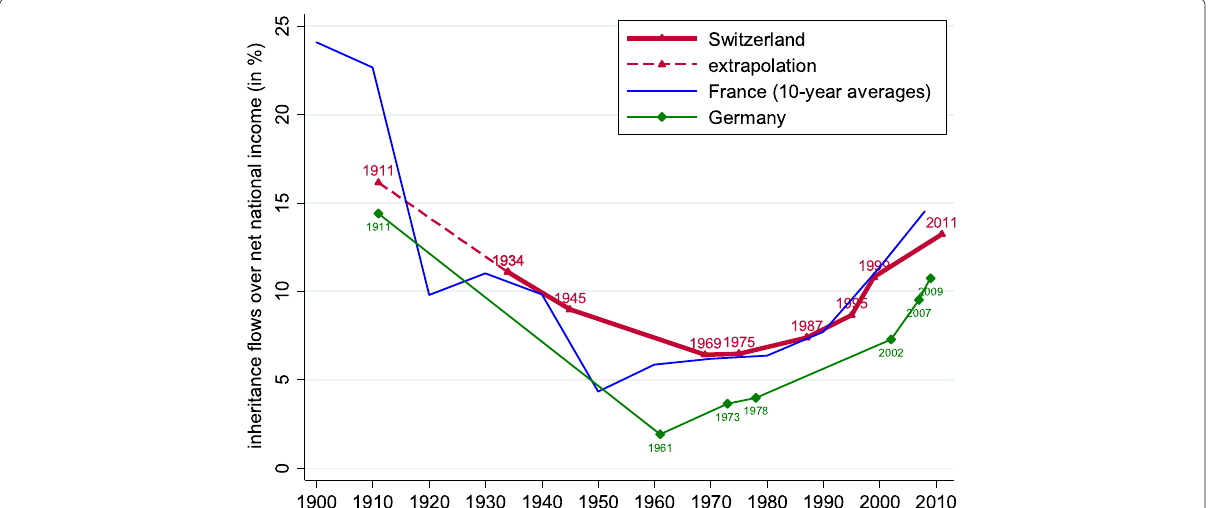
Fig. 5 Annual inheritance flow as a fraction of national income: Switzerland, France and Germany. Notes: data for France averaged by decade from Piketty (2011). Data for Germany from Schinke (2012). See text for Swiss data sources, and Table 1 for data points